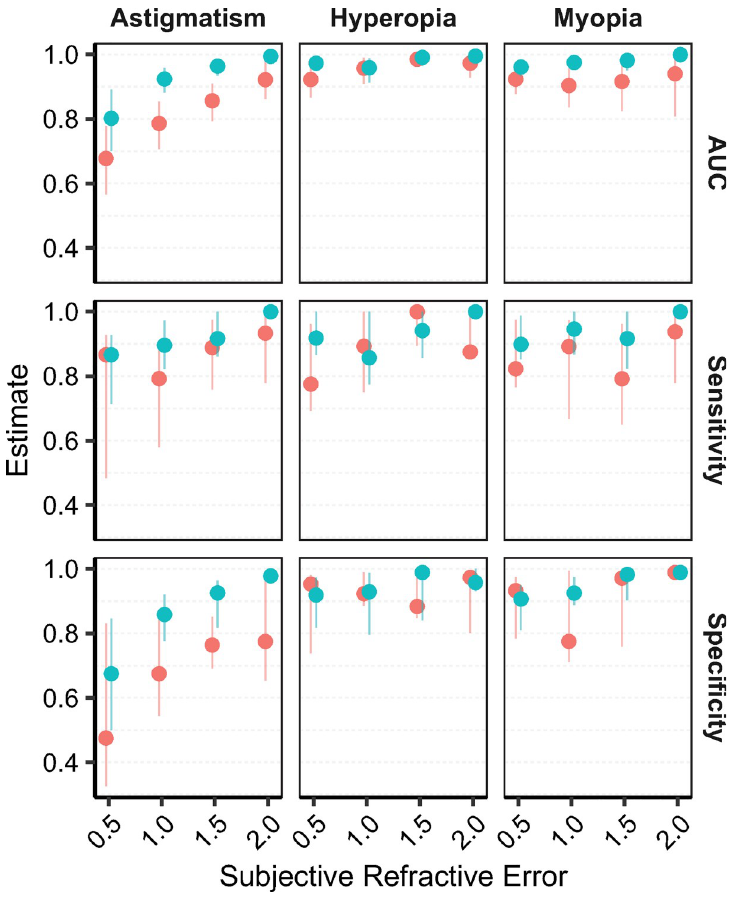
Fig 2. Area under the receiver operating characteristics (ROC) curve, sensitivity, and specificity plotted for each half-diopter of myopia, hyperopia, and astigmatism as assessed from the subjective refraction reference standard. Sensitivities and specificities were assessed from the optimal test threshold for each ROC curve, as assessed by the Youden index. The dots represent the estimate and the lines the 95% confidence interval (green = Nidek, red = 3nethra).